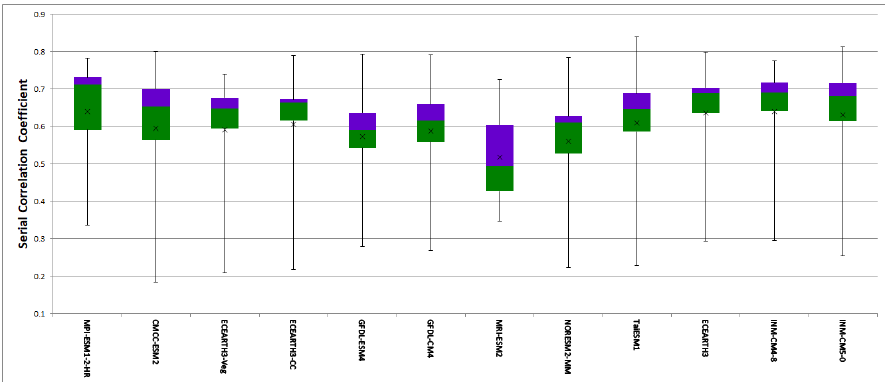
Figure 10. box plots of monthly Tmax correlation coefficients for each climate mode obtained across all climate stations in UASB.